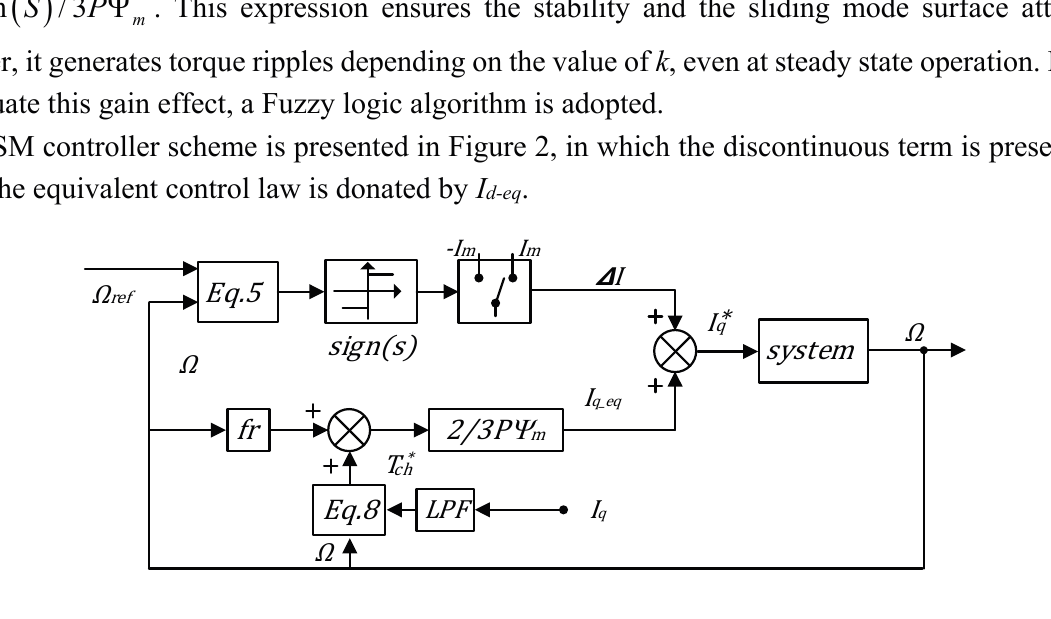
Figure 2. Sliding Mode Controller